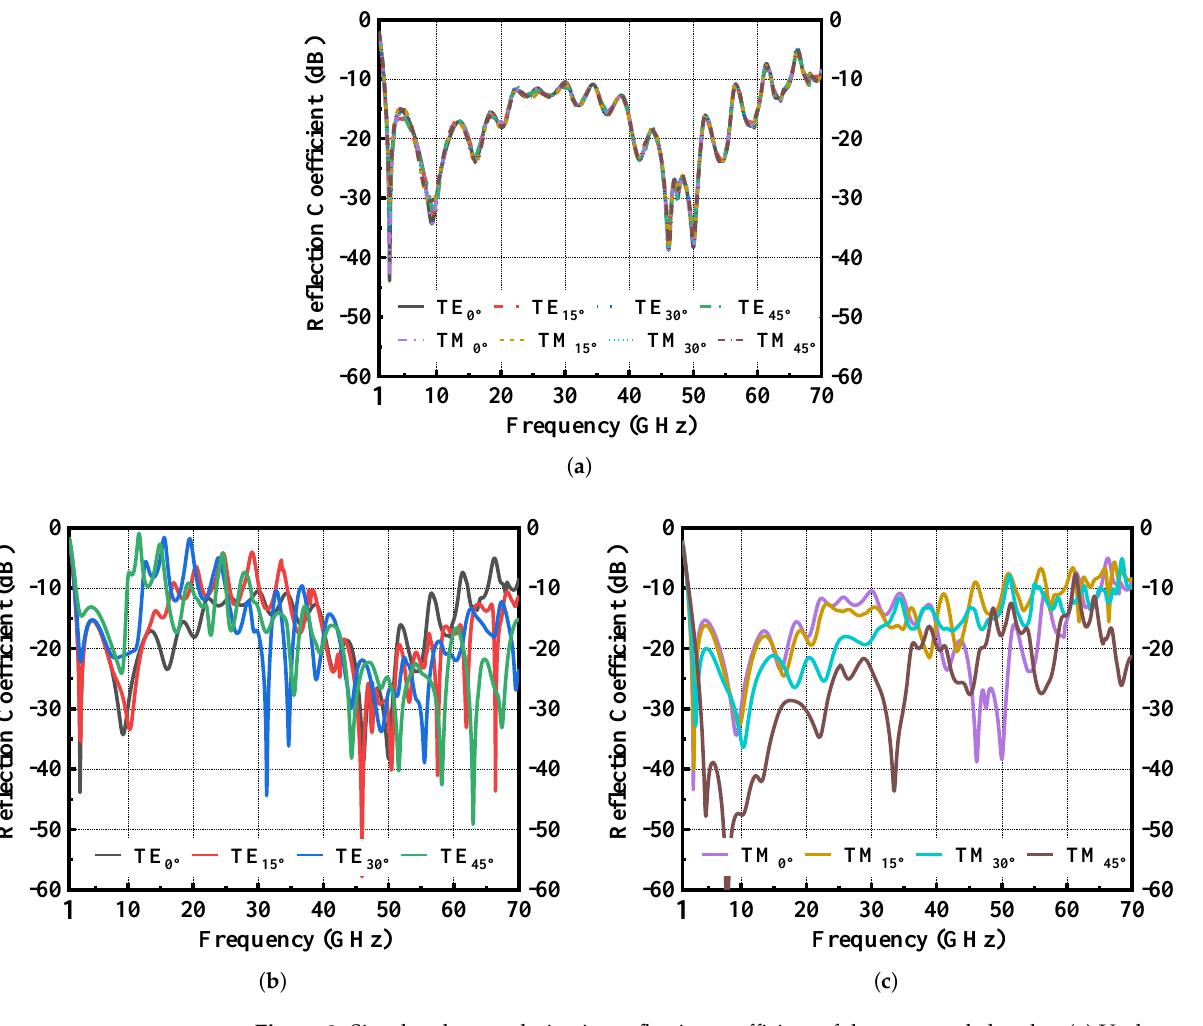
Figure 3. Simulated co − polarization reflection coefficient of the proposed absorber ( a ) Under normal incident wave with varying polarization. ( b ) Under oblique incident TE wave. ( c ) Under oblique incident TM